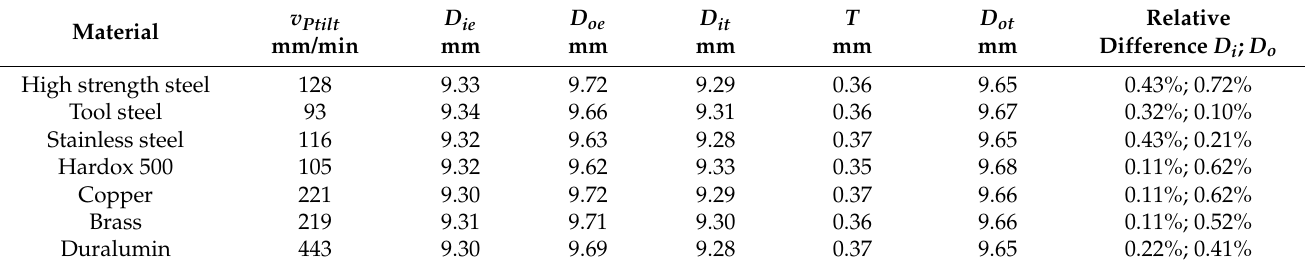
Table 4. Comparison of the theoretical calculations and the respective experimental data for the tilted cutting head.